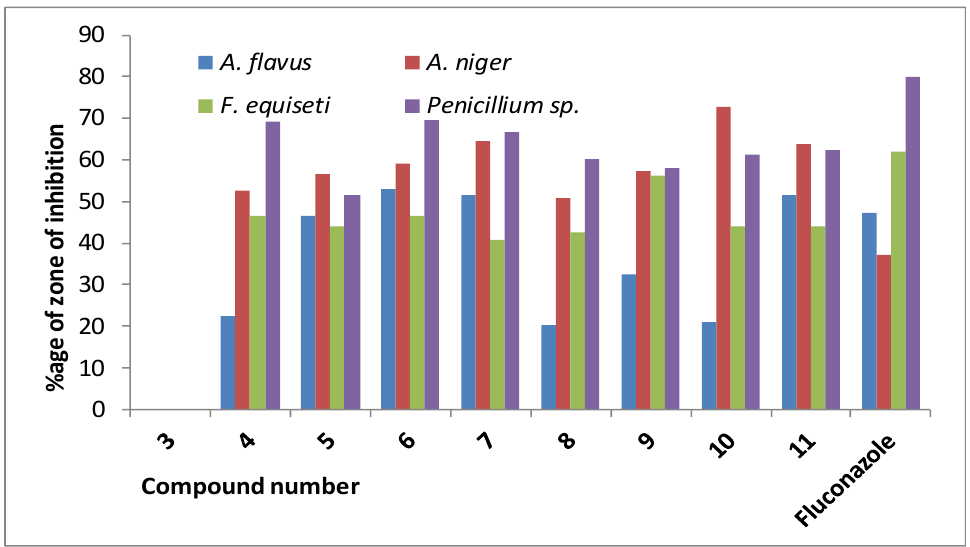
Figure 4. In vitro zone of inhibition (%) against fungal pathogens by 4 – 11 .